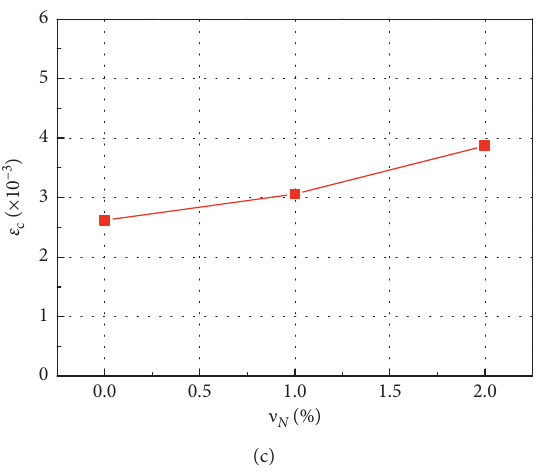
Figure 6: Effects of the nanosilica content: (a) f